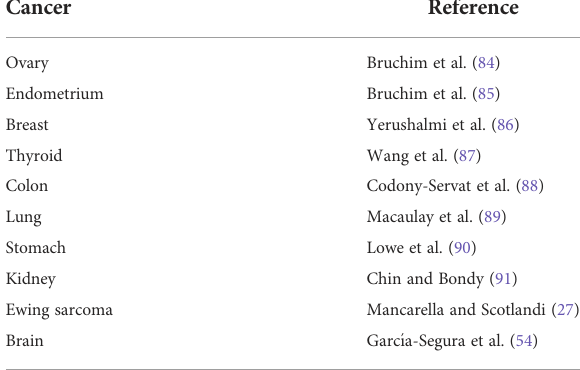
TABLE 1 IGF1R gene expression in human